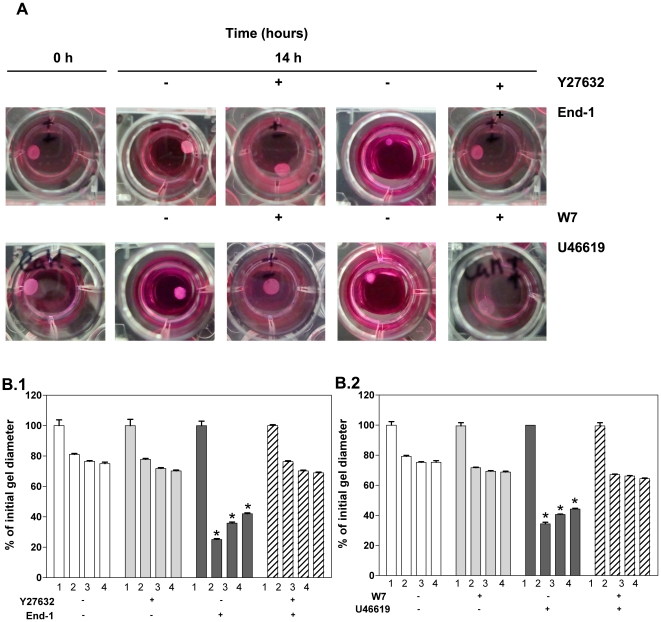
Evaluation of the role of Rho A/Rho kinase- and Ca2+/CaM/MLCK-dependent pathways in the contraction of SMPCs and hVSMCs.CD34+PDGF or CD34+RA cells were initially treated for 3 days with serum-free medium containing the agonists endothelin-1 (End-1 (10 nM), A and B.1) or U46619 (1 µM) (A and B.2) in the presence or absence of the Rho-kinase inhibitor Y27632 (13 µM) or the calmodulin inhibitor W-7 (12 µg/mL). The cells were then encapsulated in fibrin gels and the diameter of the gel assessed at time 0 (1) and 14 h (2,3,4). Graph displays the variation in gel diameter (percentage) encapsulating hVSMCs (2), CD34+PDGFBB cells (3) or CD34+RA cells (4). Data are shown as mean ± SEM (n = 6), * P<0.001 relatively to samples inhibited with Y27632 or W-7, by Student's t-test.